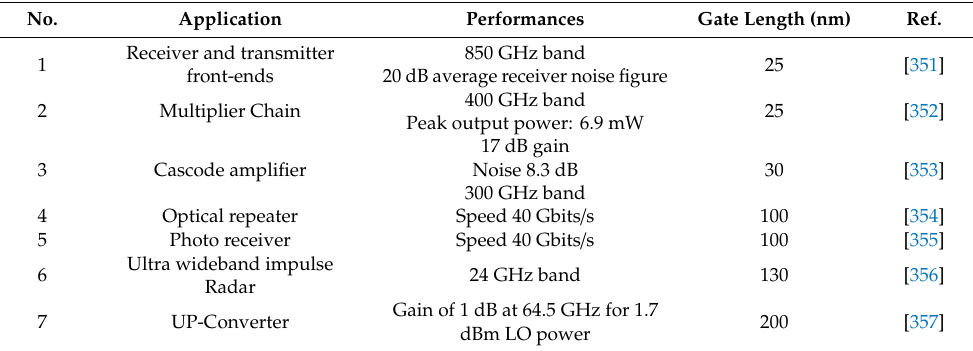
Table 2. Typical applications where InP HEMTs is involved and their features